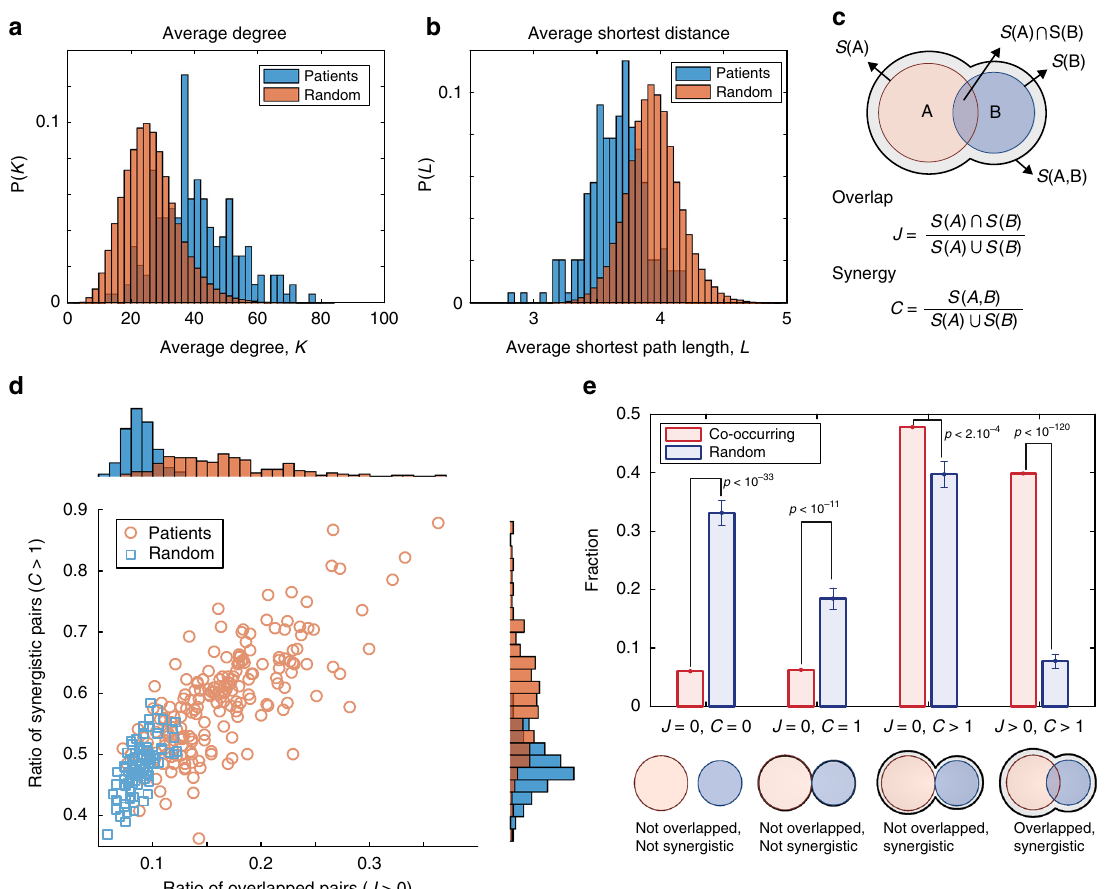
Fig. 2 Overlap between mutation-propagating modules and their synergistic effects. a Distribution of the average degree of genes that harbor somatic mutations in patients compared to the corresponding random expectation. The average degree of each patient indicates the mean degree of all the mutated genes of that patient, and the random expectation indicates the expected mean when the same number of mutations occurred randomly ( n = 1000). b Distribution of the average shortest path length between all the mutations in patients compared to the corresponding random expectation ( n = 1000). c The overlap between two mutation-propagating modules, A and B, is measured by the Jaccard index J ¼ S ð A Þ \ S ð B Þ = S ð A Þ ∪ S ð B Þ . Their synergy is measured by C ¼ S ð A ; B Þ = S ð A Þ ∪ S ð B Þ . S ( A ) denotes the size of the mutation-propagating module when a mutation A occurs, and S ( A , B ) indicates the size of the connected module when both mutations A and B occur. If A and B are close enough, S ( A , B ) would be larger than the union of S ( A ) and S ( B ). Therefore, there can be some extended area (gray), which indicates additional nodes that are in neither S ( A ) nor S ( B ). However, if A and B are far enough apart such that their modules do not overlap, S ( A , B ) would be 0. The values of J lie in the range [0, 1], with J = 0 for no common genes and J = 1 for identical gene sets between two modules. C > 1 indicates that a connected module is larger than the simple union of the single modules A and B, we call “ synergistic ” . d Ratio of synergistic pairs ( C > 1) vs. ratio of overlapped pairs ( J > 0) among all the pairs of somatic mutations for individual patients. For reducing the computational complexity, we considered only a case for randomly selected 100 mutations with 100 iterations. e The fraction of four types of connected modules within 479 co-occurring mutation pairs (see the Methods section for details), compared to the random case with the